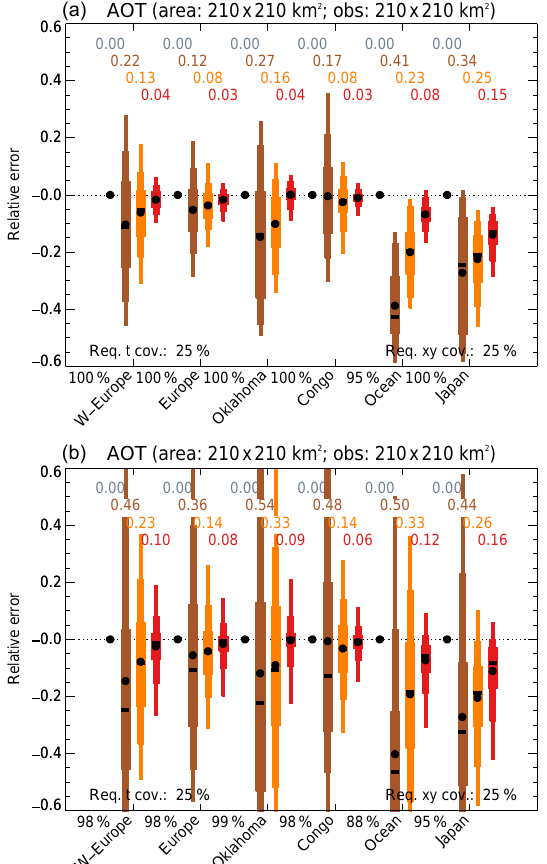
Figure 11. Analysis of monthly representation errors for an imager on a polar-orbiting satellite: purely spatial sampling (grey; this er- ror is zero by construction), spatial sampling and the observational cycle (green), spatial sampling and cloudiness (orange), and finally full spatio-temporal sampling (brown). Panel (a) is for an imager with a repeat cycle of 1 day, (b) for a repeat cycle of 8 days. Further explanation in Sect. 3.2.